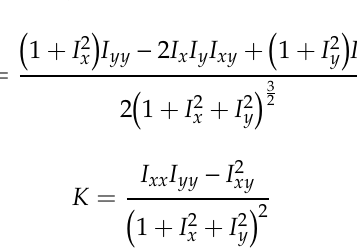
Table 3. Local surface types of points [68].